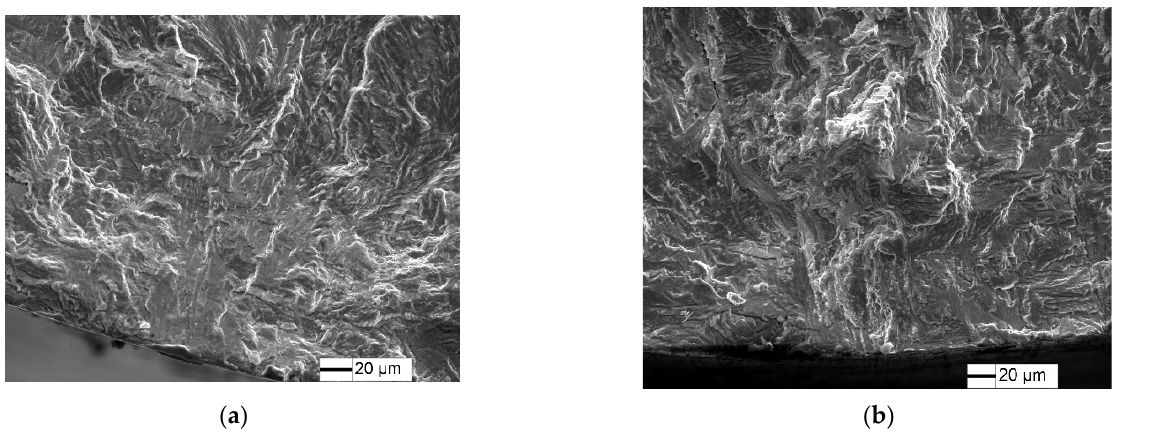
Figure 4. Fatigue fracture morphology of TC21 titanium alloy under variable amplitude: ( a ) 950 MPa/10 cycles + 450 MPa/2 × 10 5 cycles; and ( b ) 950 MPa/10 cycles + 450 MPa/2 × 10 4 cycles.